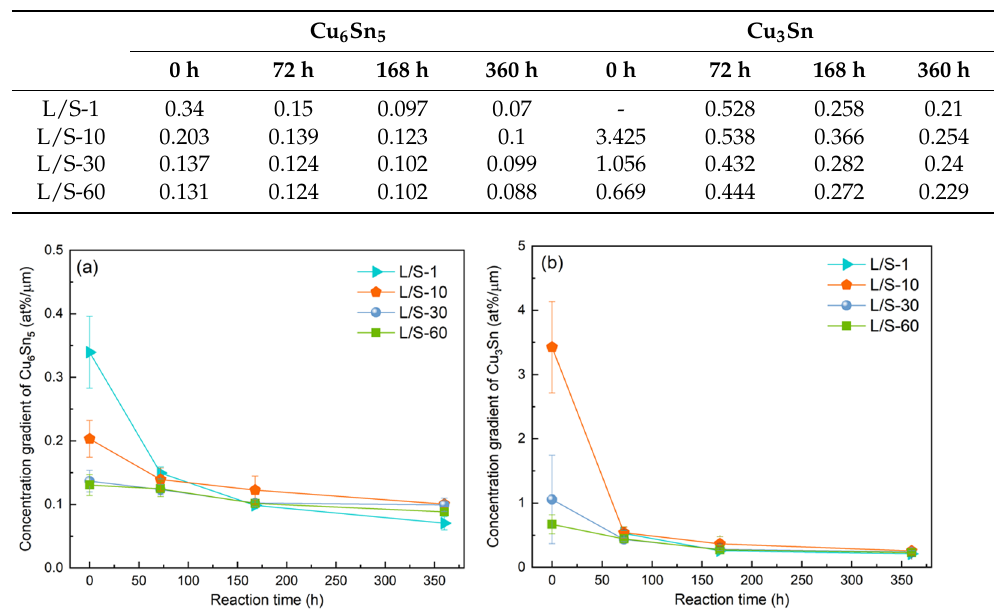
Figure 6. Increased thickness of the IMCs for various L/S reaction samples during the S/S reaction.